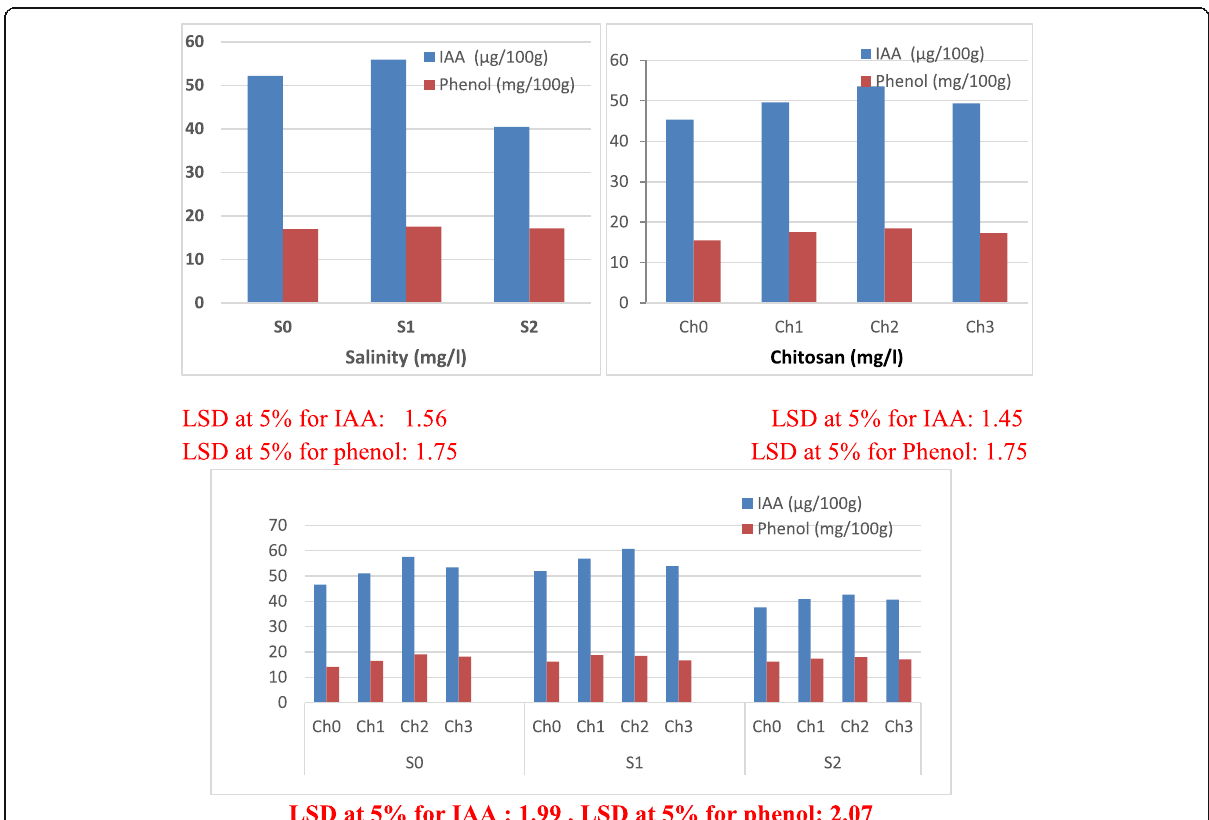
Fig. 2 Effect of salt stress, chitosan concentration and their interaction on indole acetic acid ( μ g/100 g) and phenol (mg/100 g) contents of sunflower